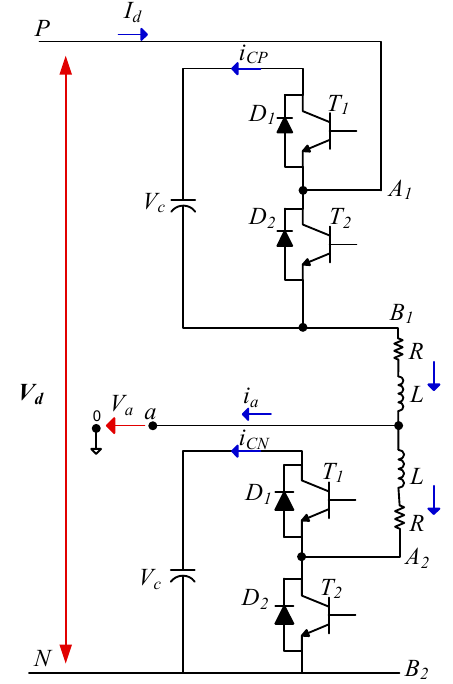
Figure 8. The one phase equivalent circuit of the MMC static synchronous compensator (STATCOM).